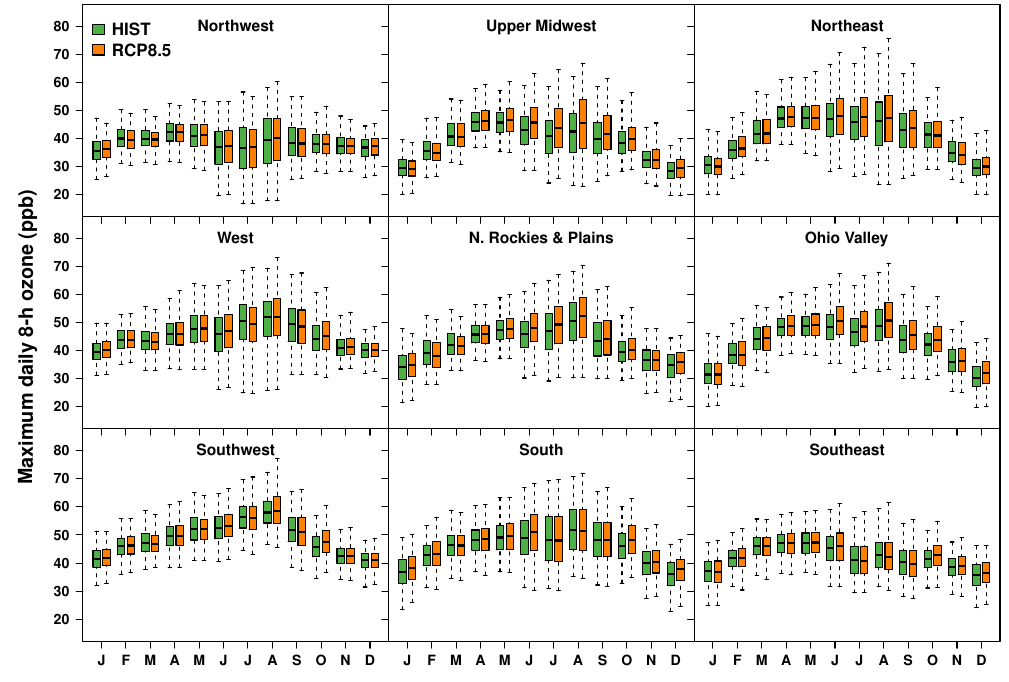
Figure 6. Monthly box plots of MDA8 O 3 simulated for the historical 1995-2005 period and 2025–2035 under RCP8.5 for each of the US climate regions shown in Fig. 1. Boxes range from the 25th to 75th percentiles with the dark line denoting the median, and whiskers extend to 2nd and 98th